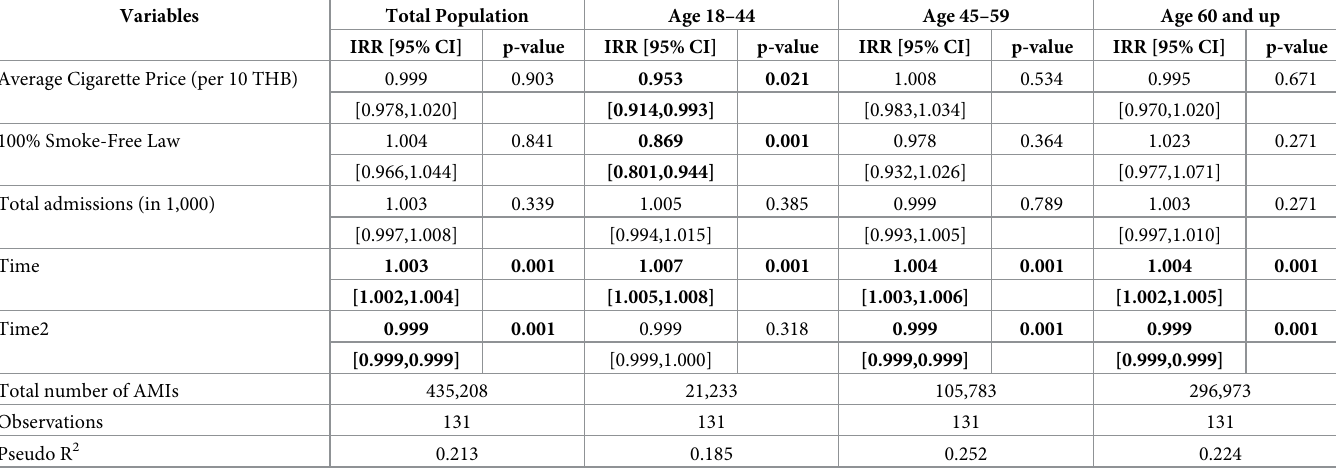
Table 2. Associations between tobacco control policies and AMI hospitalizations stratified on